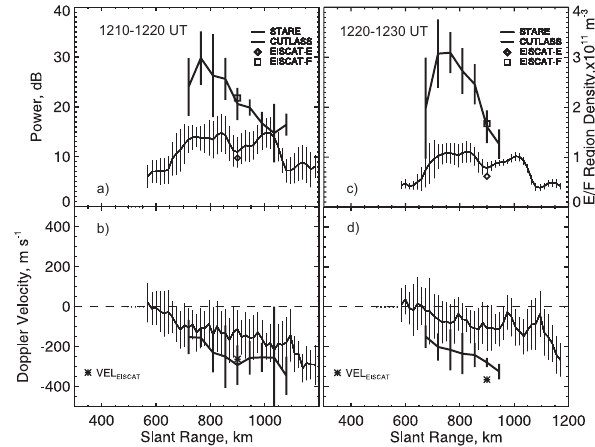
Fig. 7. Averaged slant range profiles of echo power (a, c) and Doppler velocity (b, d) for two 10-min periods of joint STARE/CUTLASS observations when CUTLASS observed F- region echoes and STARE observed E-region echoes. An asterisk (in b, d) shows EISCAT convection component along the direction of observations at the range of 900km. Square and open diamond (in a, c) show the average electron density at the heights of 250 and 110km, respectively. Scale for the densities is shown to the right of panel